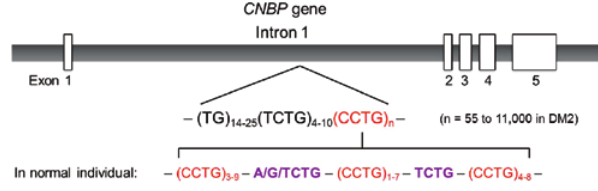
Figure 1: CCTG repeats in intron 1 of the CNBP gene. For DM2 patients, the CCTG repeat tract is uninterrupted and the repeat length can vary between 55 and ~ 11 000 repeats. For normal individuals, the CCTG repeat tract is interrupted by A/G/TCTG motifs, making the tract contains short segments of CCTG